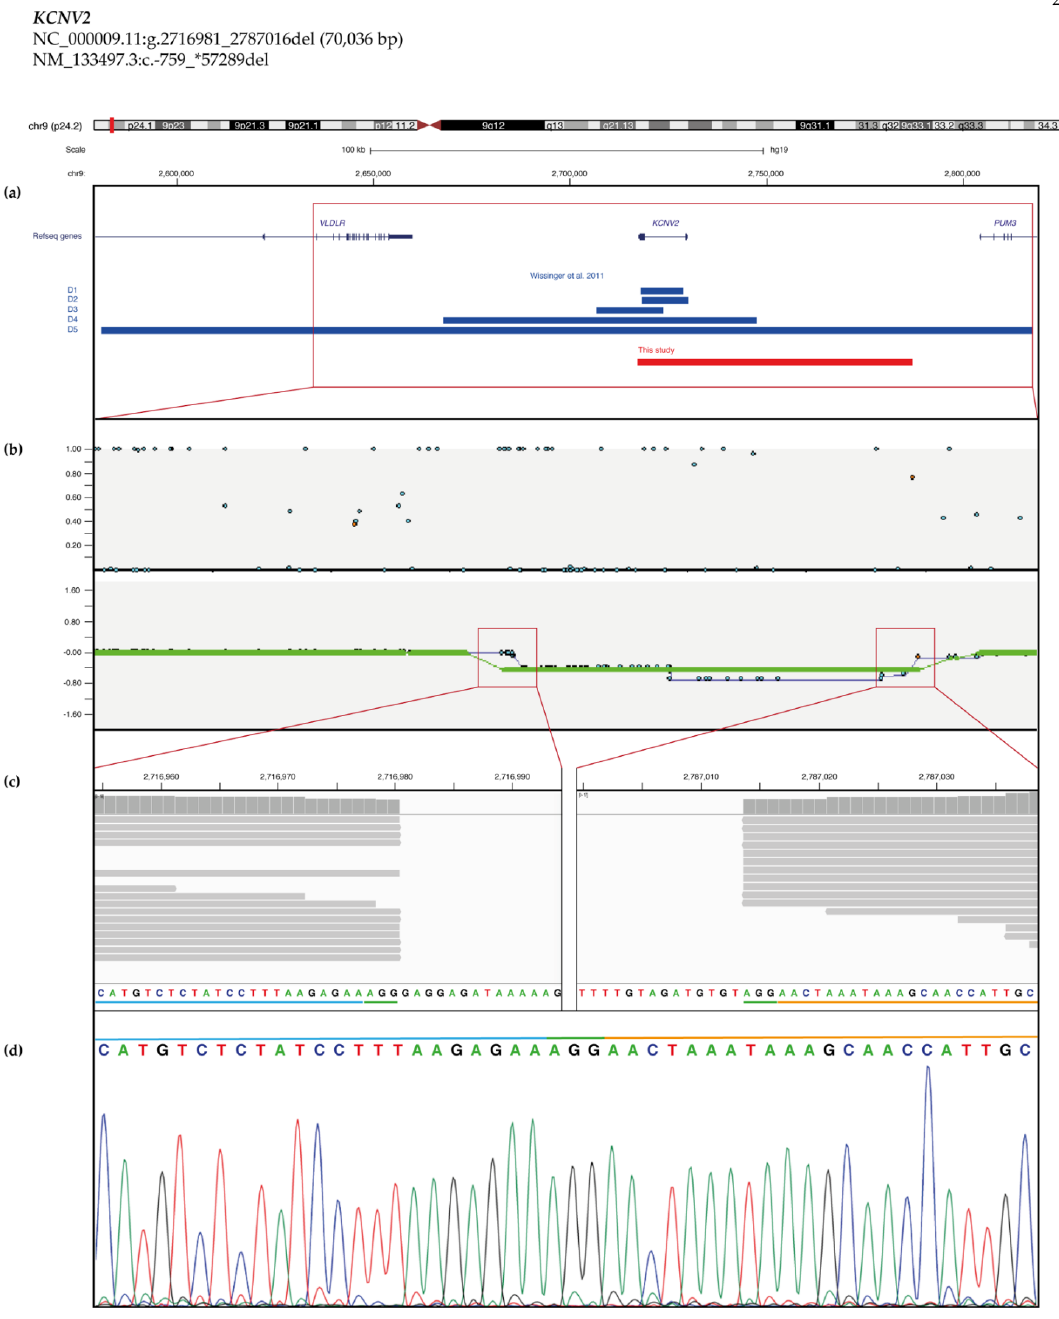
Figure A2. KCNV2 chr9:g.2716981_2787016del (70,036 bp), heterozygous. ( a ) Chromosomal overview and zoom into the KCNV2 and neighboring genes region. The figure highlights the deletions published previously by Wissinger et al. in 2011 (blue bars) [109], as well as the position of the one identified in the present study (red bar). ( b ) CytoSNP-850K BeadChip results for the KCNV2 region (corresponding to the red square in ( a )). B-allele frequency plot shown on top and the corre- sponding log R ratio plot is displayed on the bottom. ( c ) NGS alignment results for the breakpoint regions. On the left, the 5’ side breakpoint alignments are shown. The sequence is illustrated underneath the reads. The blue line underneath the sequence highlights the part of the junction region that originates from the proximal side of the deletion. The green line marks the 3 bp-long homologous sequence that is present on both sides of the deleted region. Finally, the orange line shows the part of the sequence coming from the distal side. ( d ) Electropherogram of the junction fragment for the index patient. The resulting sequence is reported above the peaks. The fragments of the proximal, distal and the shared homol- ogous sequences are highlighted with blue, orange, and green lines, respectively.